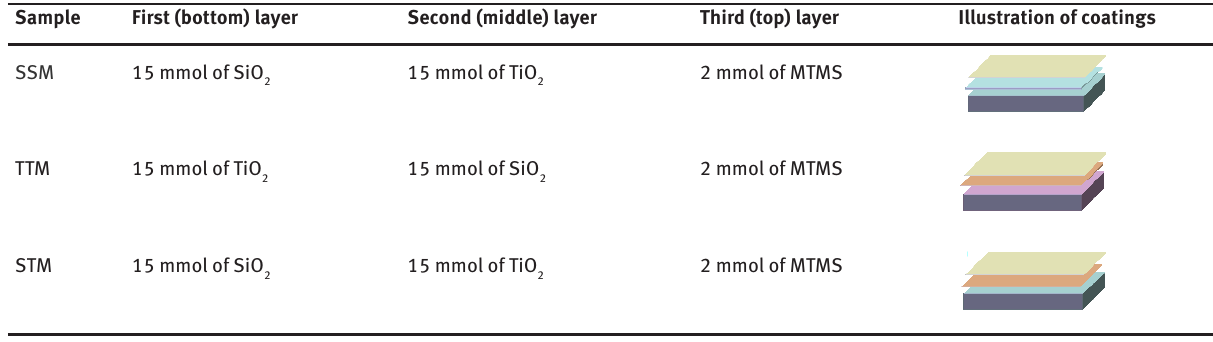
and TiO layer on MTMS coated glass. 2 2